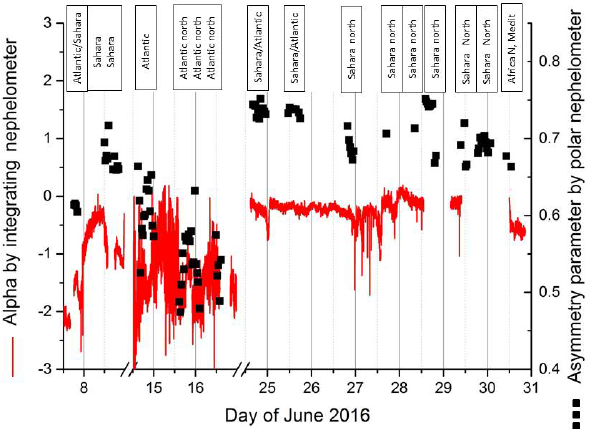
Figure 4. Angström exponent of the spectral scattering coefficient of the aerosol measured and classification by back trajectories. For the desert aerosol the Angström exponent is larger than − 1. In ad- dition, the asymmetry parameter is plotted too; for desert aerosol it is larger than 0.65.